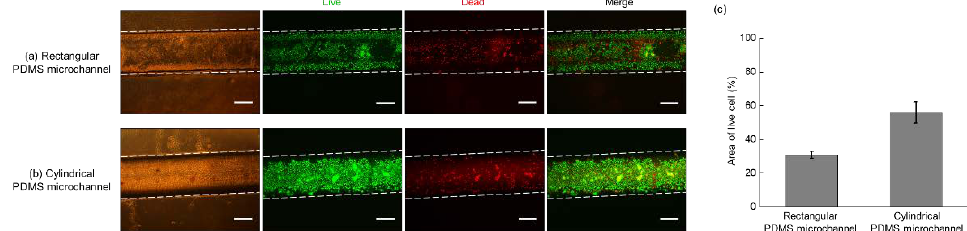
Figure 7. Results of the live/dead cell assay performed on HUVECs cultured in a PDA-coated PDMS microchannel for 3 days. ( a ) Rectangular, ( b ) cylindrical PDMS microchannels, and ( c ) the percentage of area occupied by live cells in each channel. Scale bar = 500 μm.